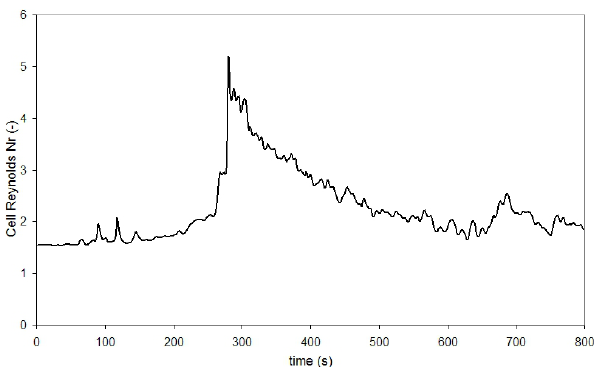
Fig. 7. Rate of the physical diffusivity to numerical diffusivity (Eq.